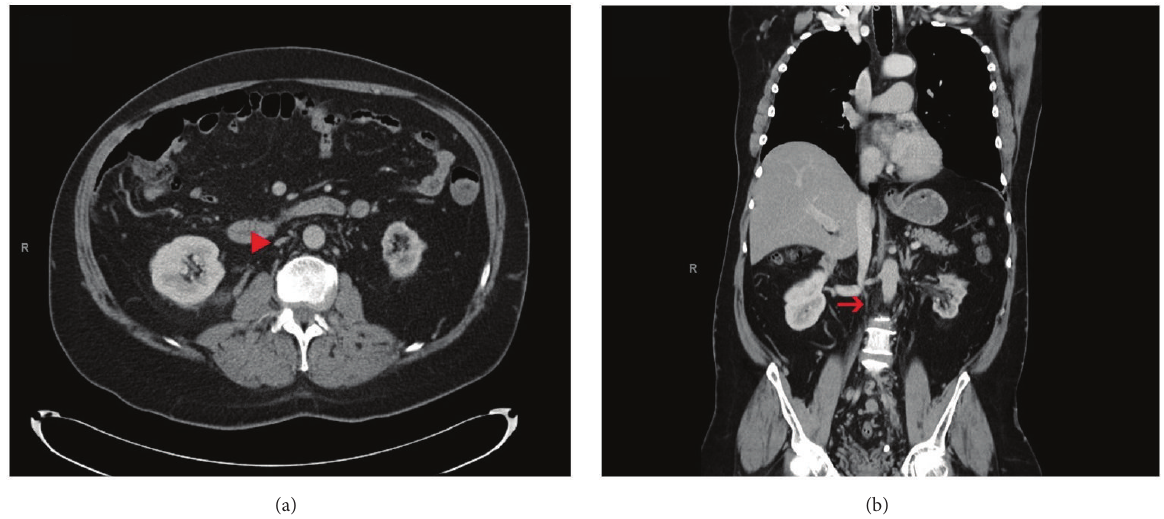
Figure 1: (a) Axial CT of the abdomen shows fibrosed infrarenal IVC (arrowhead). (b) Coronal CT of the abdomen shows thread-like fibrosis of the infrarenal IVC (arrow); note the presence of the IVC proximal to the renal